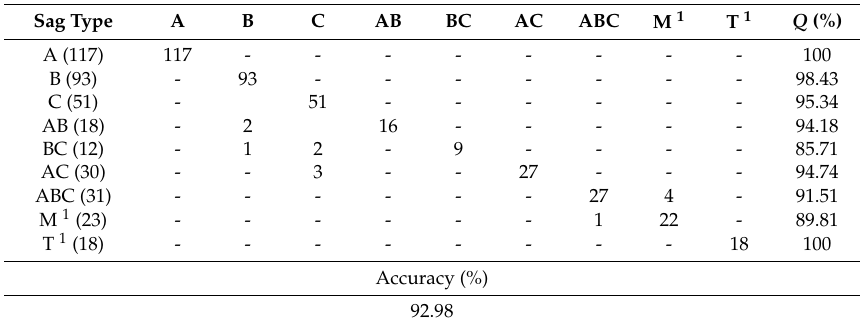
Table 4. Experiment 3 results.